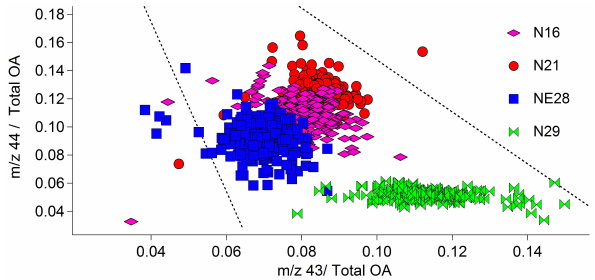
Fig. 5. Fraction of OA44 to total OA ( f 44 ) against the fraction of OA 43 to total OA ( f 43 ) for N16, N21, NE28, and N29. The black dotted lines show boundaries set by Ng et al.